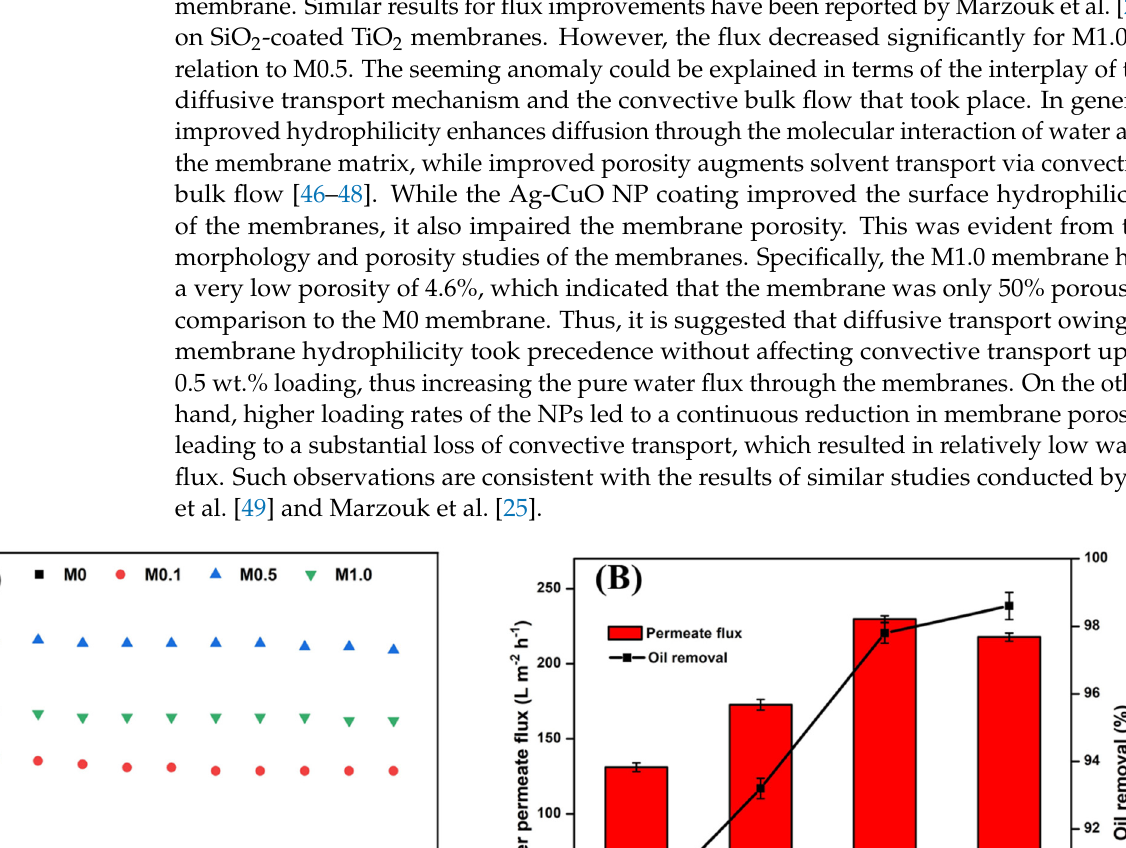
Table 1. Antifouling performance of the pristine and Ag-CuO NP-coated membranes